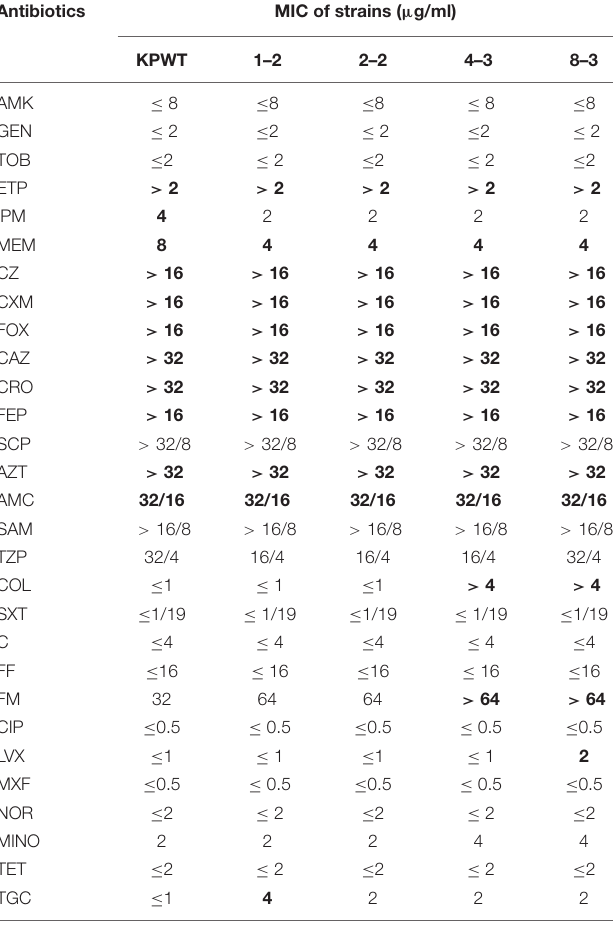
TABLE 1 | Antimicrobial susceptibility of KPWT and its induced descendant strains.